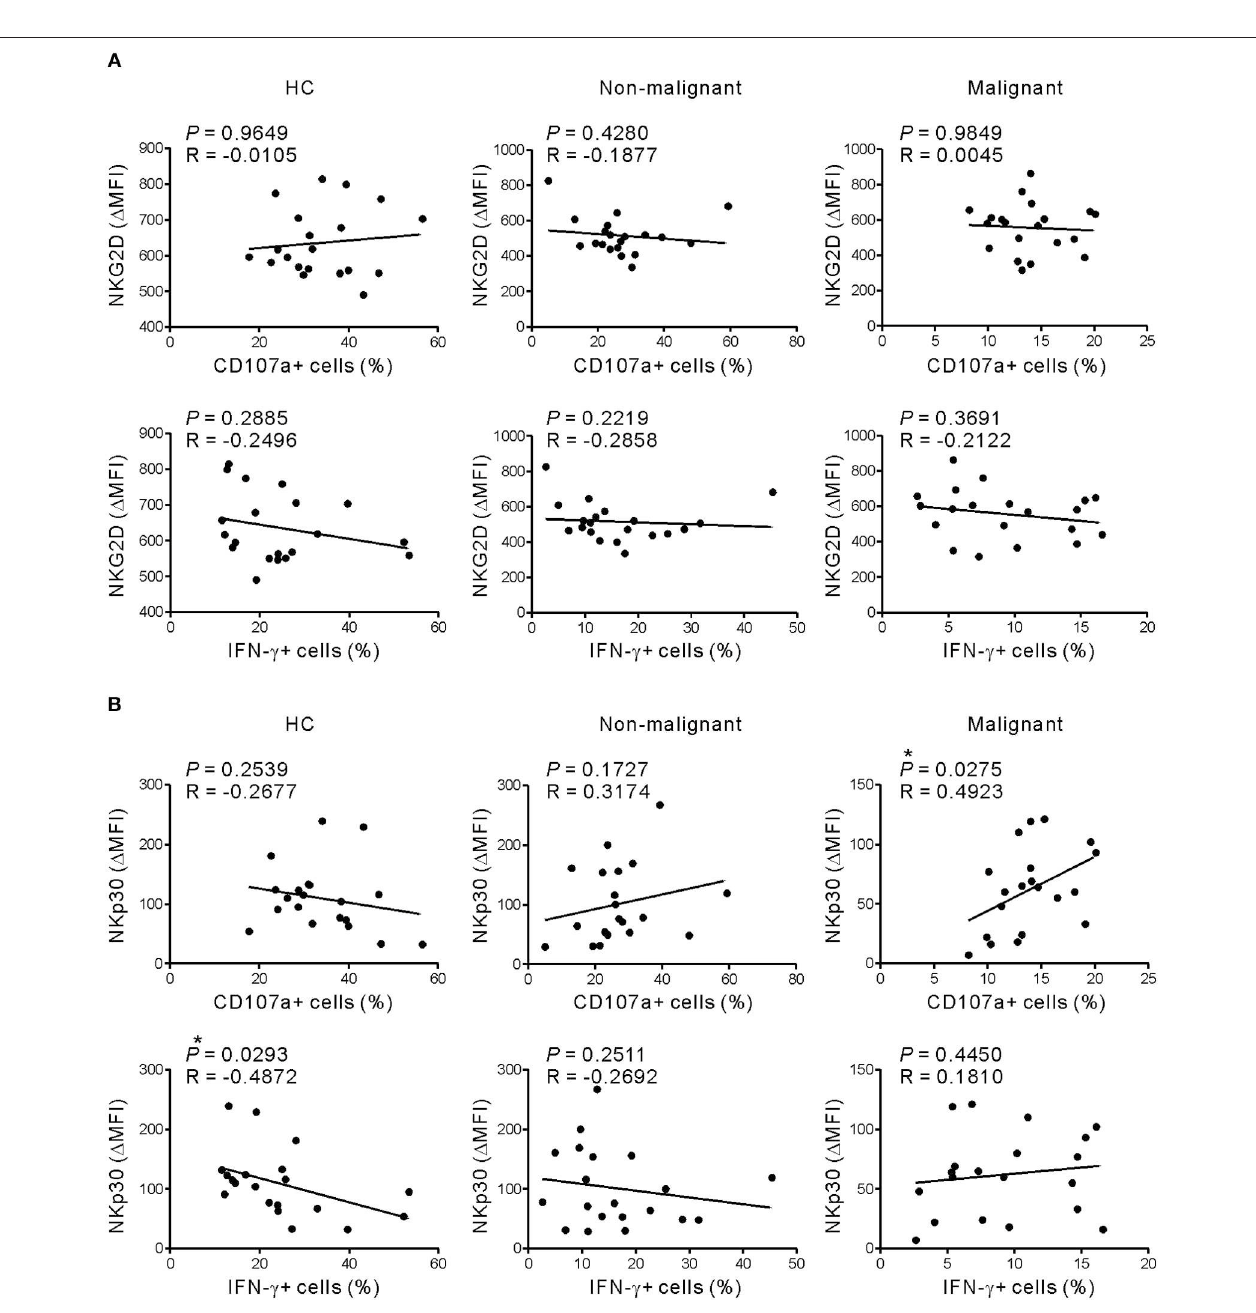
FIGURE 5 | NKG2D expression does not correlate with NK cell dysfunction in response to receptor coactivation. (A) The expression of NKG2D ( 1 MFI) was not correlated with the percentages of CD107a- or IFN- γ -positive NK cells after stimulation with P815-ULBP1 + CD48 cells. (B) The expression of NKp30 ( 1 MFI) correlated positively with the percentage of CD107a-positive NK cells in the malignant group after stimulation with P815-ULBP1 + CD48 cells. * P < 0.05; Spearman’s correlation test.